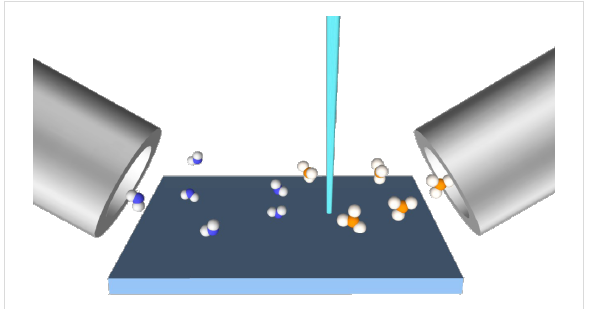
Figure 10: Illustration of two adsorbate FEBIP where the molecules are supplied by two capillaries and impinge with fluxes F e and F d